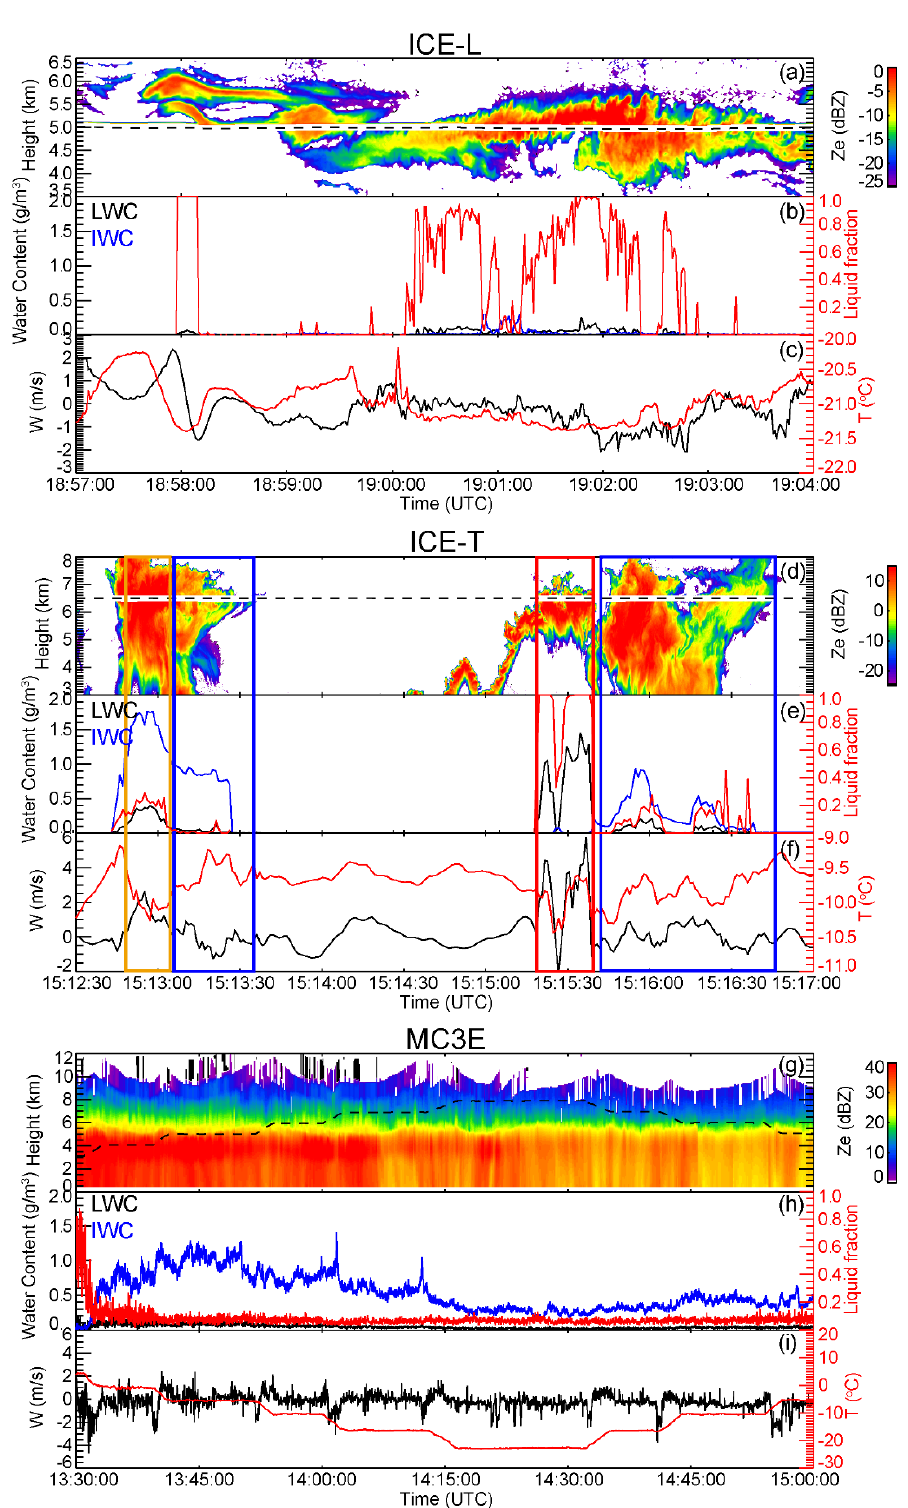
Figure 2. Examples of clouds sampled during ICE-L, ICE-T, and MC3E, including radar Ze ( a , d , g ), flight-level LWC, IWC, and liquid fraction ( b , e , h ), and vertical velocity and temperature ( c , f , i ). The Ze in ( a , d ) were measured by WCR in ICE-L and ICE-T, and Ze in ( g ) was measured using the WSR-88D scanning radar. The dashed lines in ( a , d , g ) indicate the flight levels. The red, orange, and blue boxes in ( d – f ) indicate the developing cloud, the mature cloud, and the dissipating cloud/ dissipating part of a mature cloud, respectively.